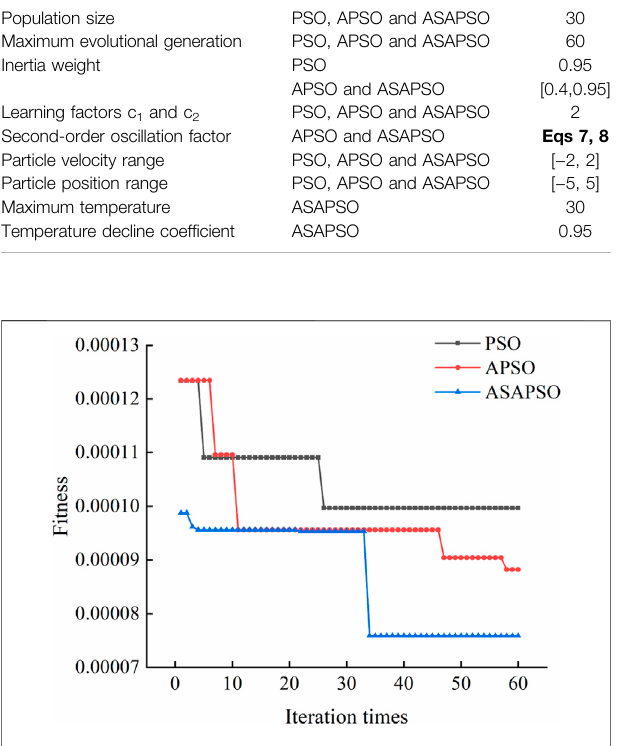
FIGURE 10 | The evolution curve of these